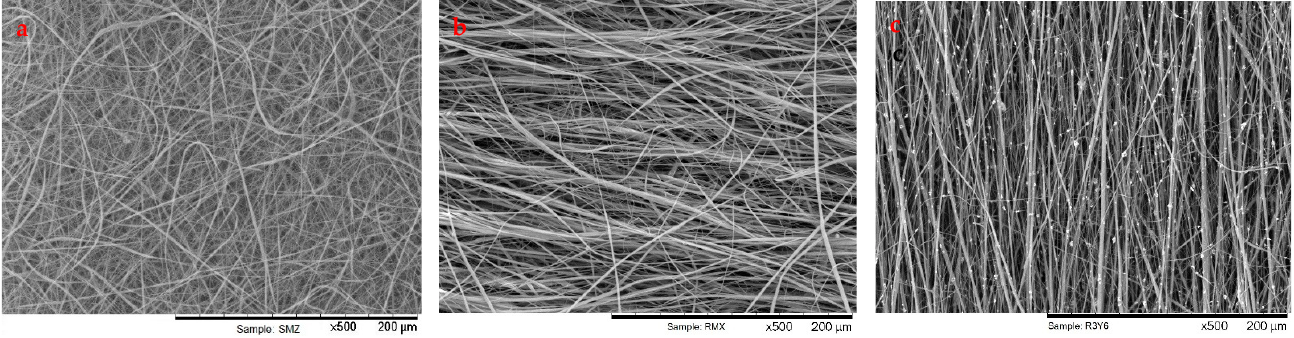
Figure 1. SEM images of membranes ( a ) SMZ, ( b ) RMX, and ( c ) R3Y6 at 500 × magnification. As expected, the membranes produced with the static collector show no sign of alignment at all, whereas the rotating collector proved to promote the alignment of fibers significantly for RPM above 2500. Membrane R3Y6 showed the best alignment of all membranes. The membranes produced with the same set of electrospinning parameters, regardless of being with and without particles, exhibited the best alignment.